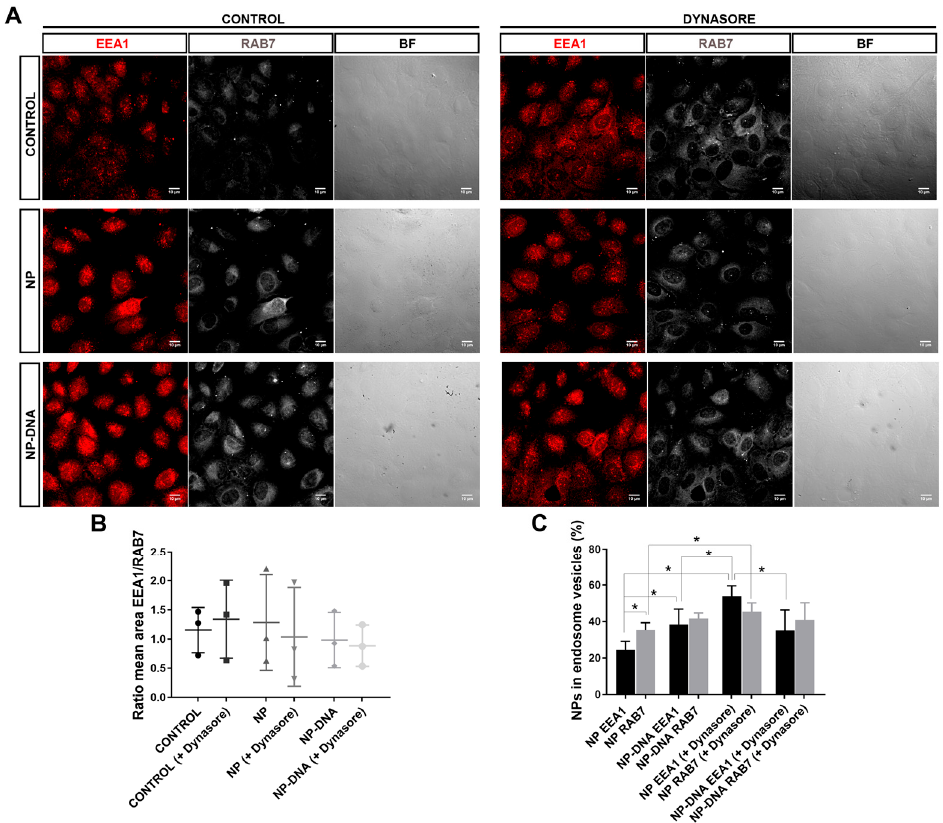
Figure 3. A significant pool of DNA-wrapped gold NPs colocalized in early and late endosomes in di ff erentiated ARPE-19 cells. ( A ) After 2 h post-transfection, a significant pool of NPs colocalized in early endosomes (early endosome marker EEA1, in red) and late endosomes (mature endosome marker RAB7, in white). NPs are visualized as black dots in the optic transmission microscopy channel (BF). Dynasore treatment (panels at the right) was also performed to inhibit dynamin-mediated uptake events. The merge field is not shown since nanoparticles were not distinguishable on the dark background of immunofluorescent images, but image analyses of colocalization were performed by using masks over di ff erent channels. ( B ) The number of early and late endosomes was analysed as a ratio (to normalize per cell and condition). After 2 h of transfection with NPs, the ratio EEA1 / RAB7 was variable but not significantly di ff erent either between cells treated with dynasore compared to controls or between control cells compared to cells transfected with pristine gold NPs or DNA nanoparticles. ( C ) Percentage of pristine NPs and DNA–nanoparticle colocalization with early or late endosomes / cell. At 2 h post-transfection, NPs showed a fluid tra ffi cking between early and late endosomal compartments, as detected by 35% localization in late (35%) versus 25% in early endosomes. Instead, DNA NPs showed a higher localization in the endosomal compartment (close to 100%) but with a similar distribution between early and late endosomes. The addition of dynasore changed the proportion of NPs detected in early and late endosomes when analysing pristine NPs, but not when analysing DNA NPs, indicating that internalization and intracellular tra ffi cking routes di ff er between pristine gold NPs and DNA NPs. Representative images from three independent replicates (three images per replicate and condition) were quantified. Statistical significance was analysed by the non-parametric Mann–Whitney test (* indicates p < 0.05).